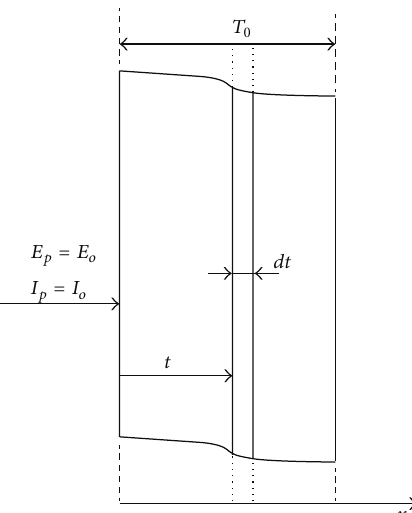
Figure 6: The main parameters in the slab approximation geometry for the calculation of yield distributions inside molybdenum sample